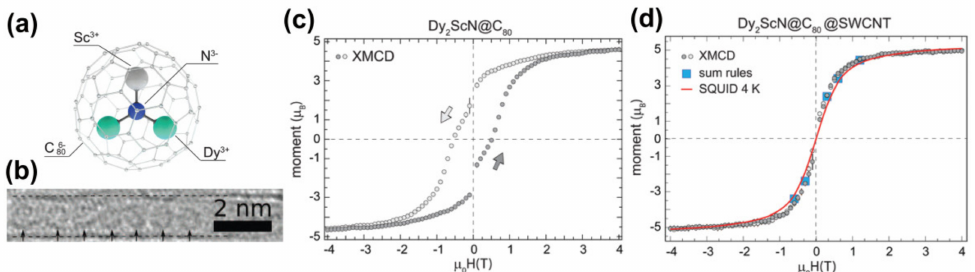
Figure 5. ( a ) Ball-and-stick model of Dy 2 ScN@C 80 . ( b ) HRTEM image of a chain of Dy 2 ScN@C 80 inside a SWCNT. (c) Element-specific magnetization curves recorded at the Dy M 5 − edge with at 2 K of bulk Dy 2 ScN@C 80 ( c ) and Dy 2 ScN@C 80 encapsulated in SWCNTs ( d ). The plotted magnetization curves are the average of several independent measurements. The black error bars are the standard deviation at each external magnetic field. The scale of the magnetization curves is determined by the magnetic moments obtained by the sum-rule analysis of the XMCD data. The red magnetization curve in ( d ) was measured by a SQUID at 4 K. Reproduced from [187]. Published by the Royal Society of Chemistry under a Creative Commons Attribution-Non-commercial 3.0